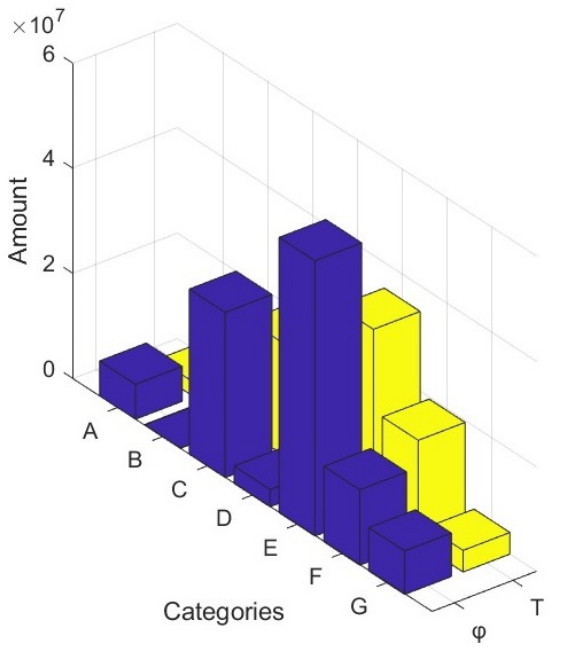
Figure 18. Comparison of Utilization Amount in each